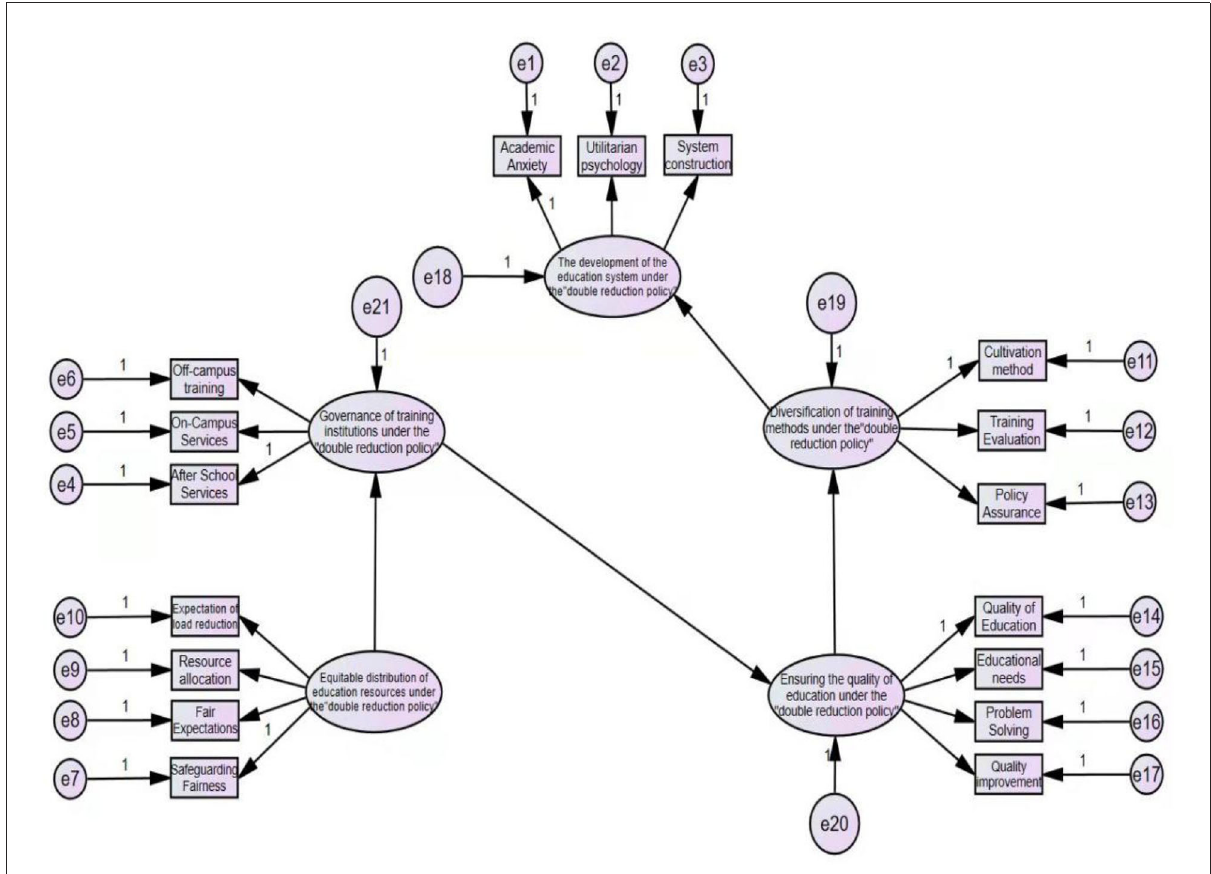
FIGURE2 Amos structural equation